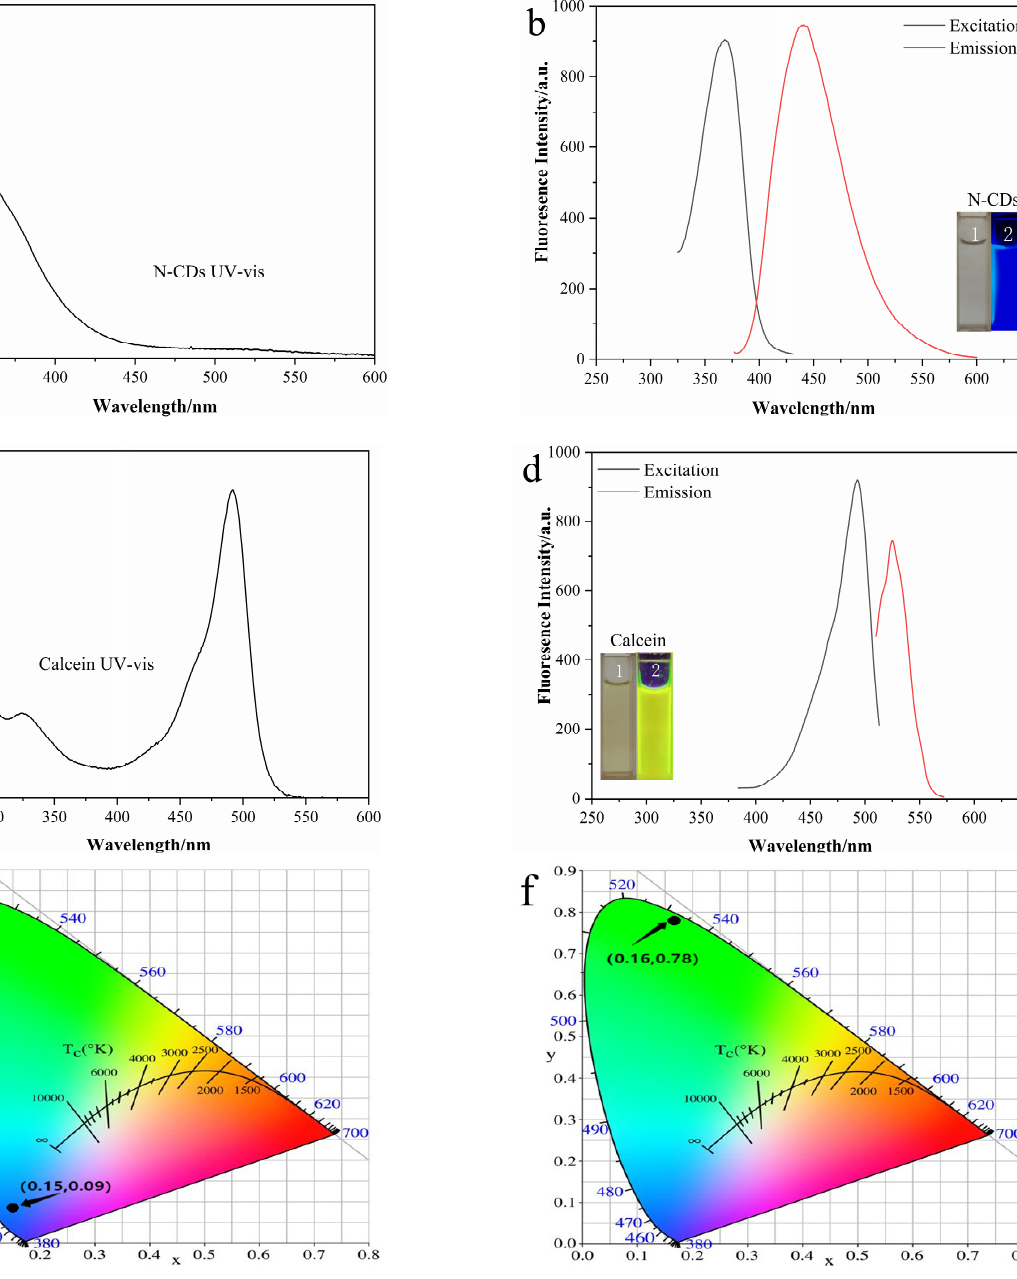
Figure 4. ( a ) UV–vis spectra of N-CDs; ( b ) fluorescence spectra of N-CDs; ( c ) UV–vis spectra of calcein; ( d ) fluorescence spectra of calcein; ( e ) calculated CIE coordinates according to the fluorescence spectrum of N-CDs; ( f ) calculated CIE coordinates according to the fluorescence spectrum of calcein. The insets show the corresponding fluorescence colors.